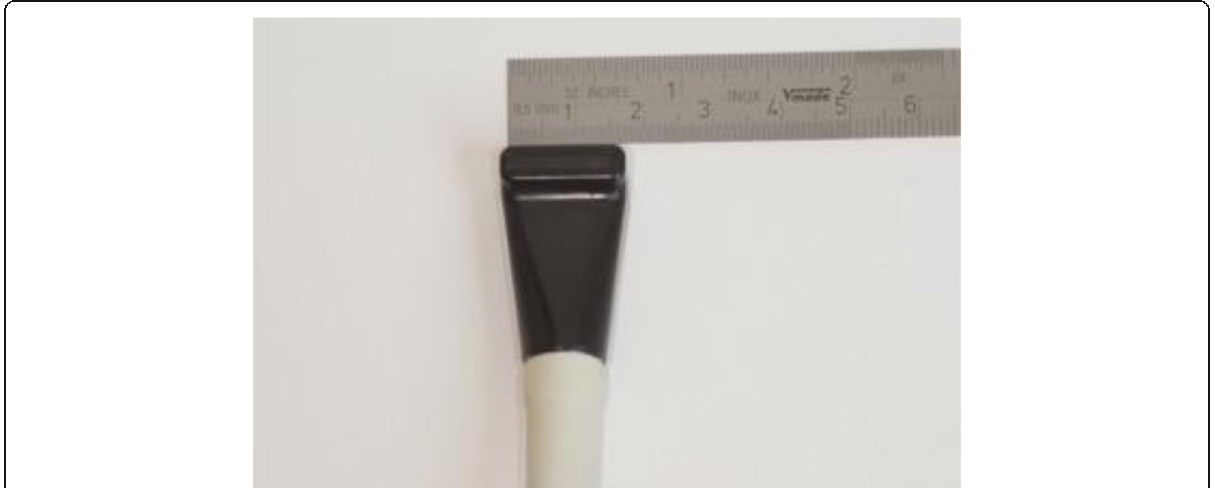
Fig. 2 High-frequency probe (up to 60 μ m, model L30-8, Mindray Innovation Center, Mindray North America, San Jose, CA, USA) with the size of